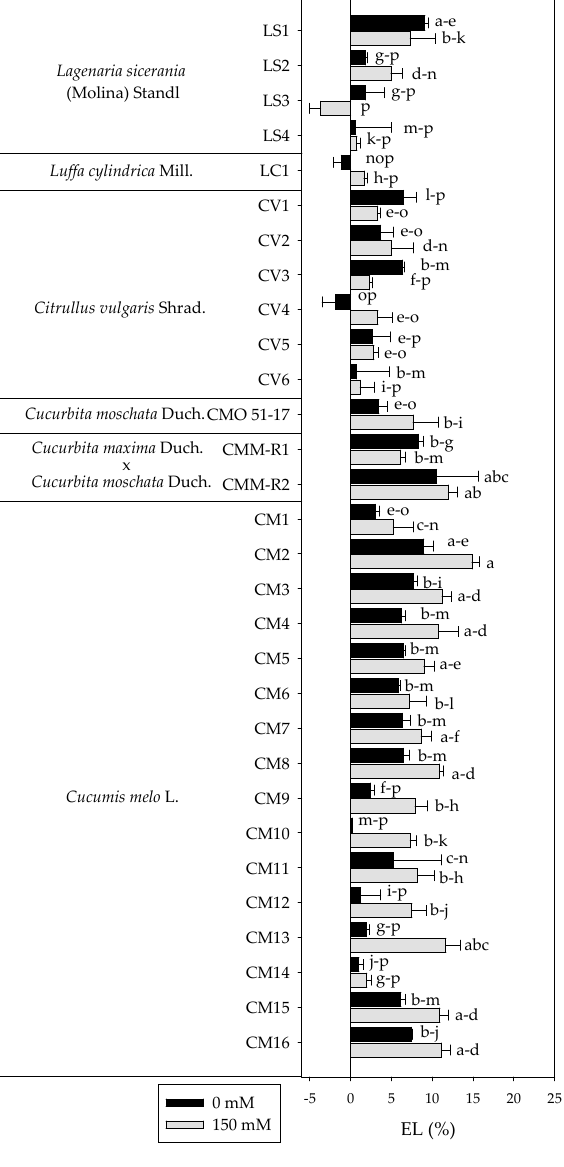
Figure 4. Electrolyte leakage (EL) in leaves, after one week of NaCl treatment, in seedlings of sixteen Cucumis melo L., six Citrullus vulgaris Schrad., two C. maxima × C. moschata , four Lagenaria siceraria (Molina) Standl. different genotypes, and Cucurbita moschata Duch. cv 51–17 and Luffa cylindrica Mill. Mean values ± standard errors; n = 3 followed by different letters within each parameter are significantly different based on Duncan post hoc ( p < 0.05).